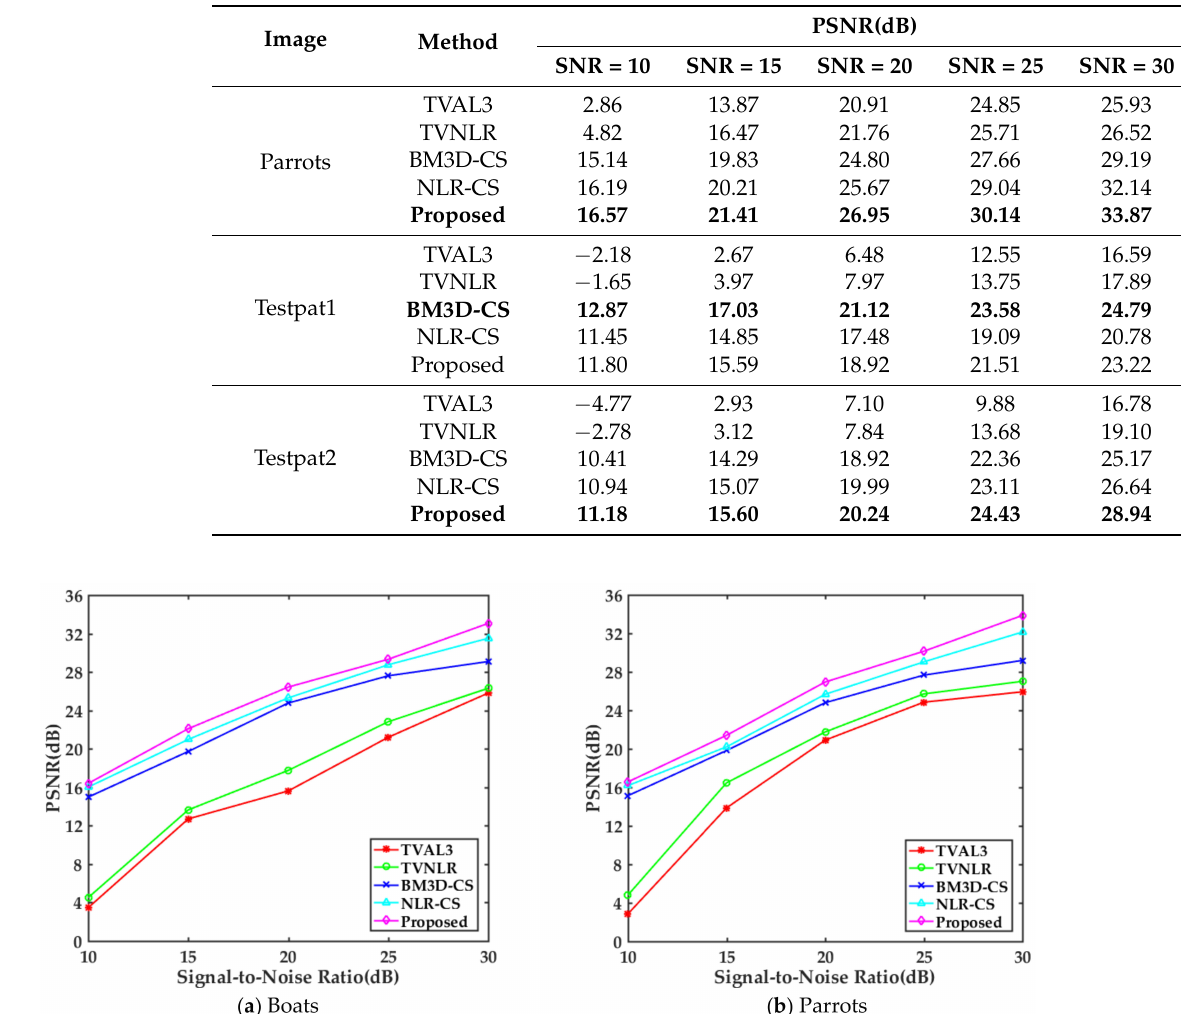
Figure 8. The PSNR (dB) curves of the ( a ) Boats and ( b ) Parrots images reconstructed at 20% sampling rate from noisy measurements.